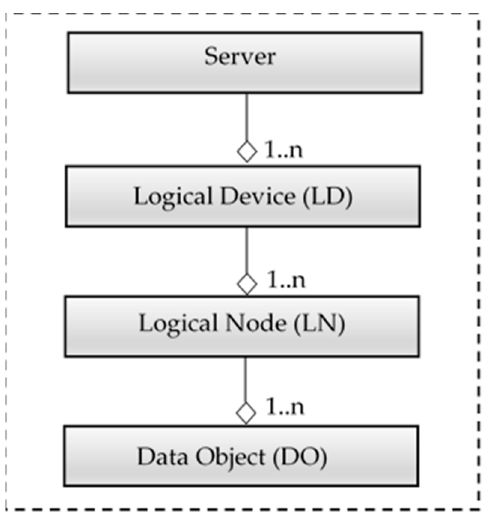
Figure 1. IEC 61850 Information Model.